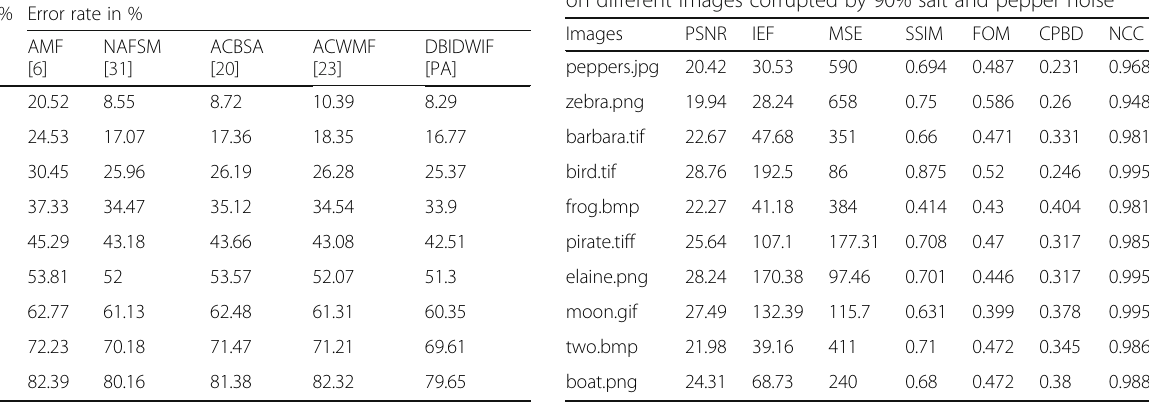
Table 6 Quantitative performance of the proposed algorithm on different images corrupted by 90% salt and pepper noise Images